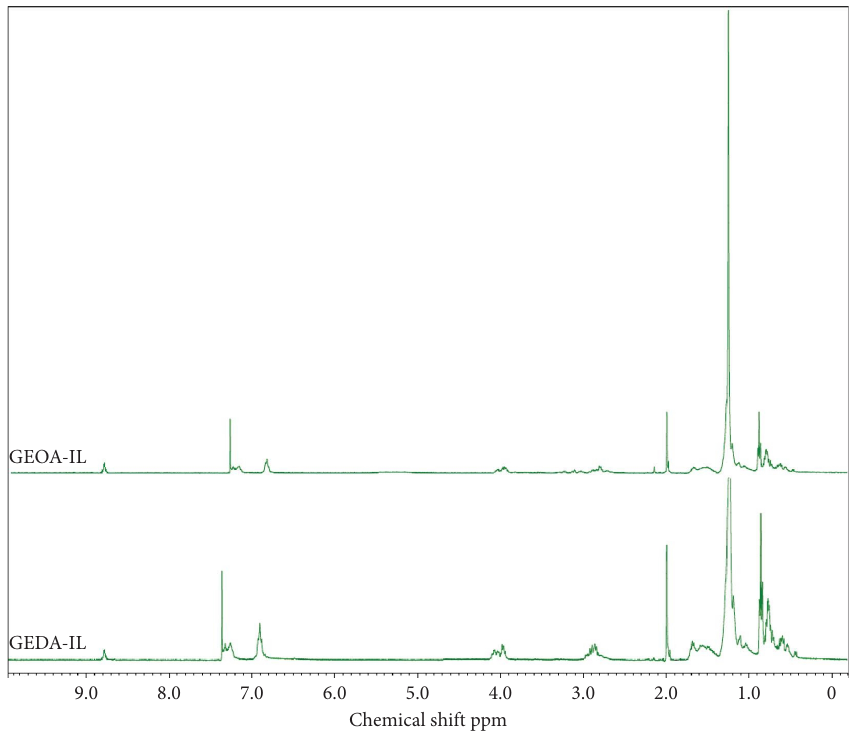
Figure 2: 1 H-NMR of GEOA-IL and